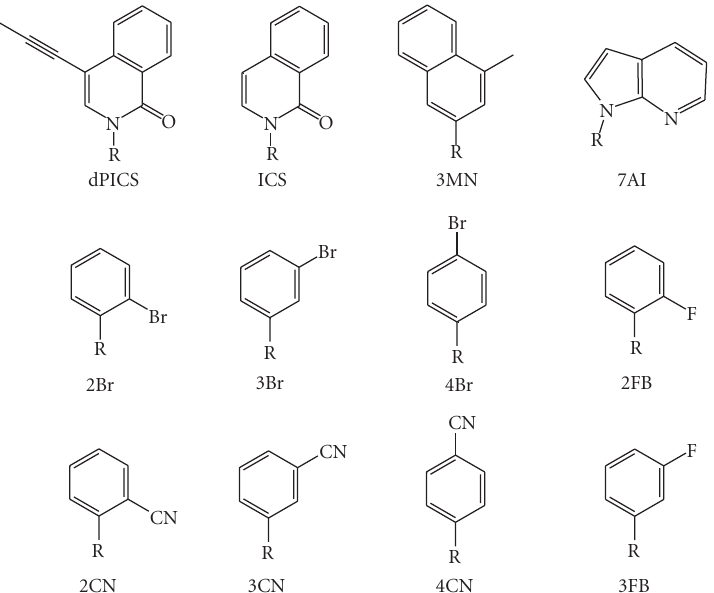
Figure 4: Hydrophobic nucleobase analogs: 7-propynyl isocarbostyril nucleoside (dPICS) [84]; isocarbostyril nucleoside (ICS); 3- methylnaphthalene (3MN); azaindole (7AI) [85]; bromo phenyl derivatives at positions 2, 3, and 4 (2Br, 3Br, and 4Br, resp.); cyano derivatives at positions 2, 3, and 4 (2CN, 3CN, and 4CN, resp.), fluoro derivatives at positions 2 and 3 (2FB, 3FB, resp.)